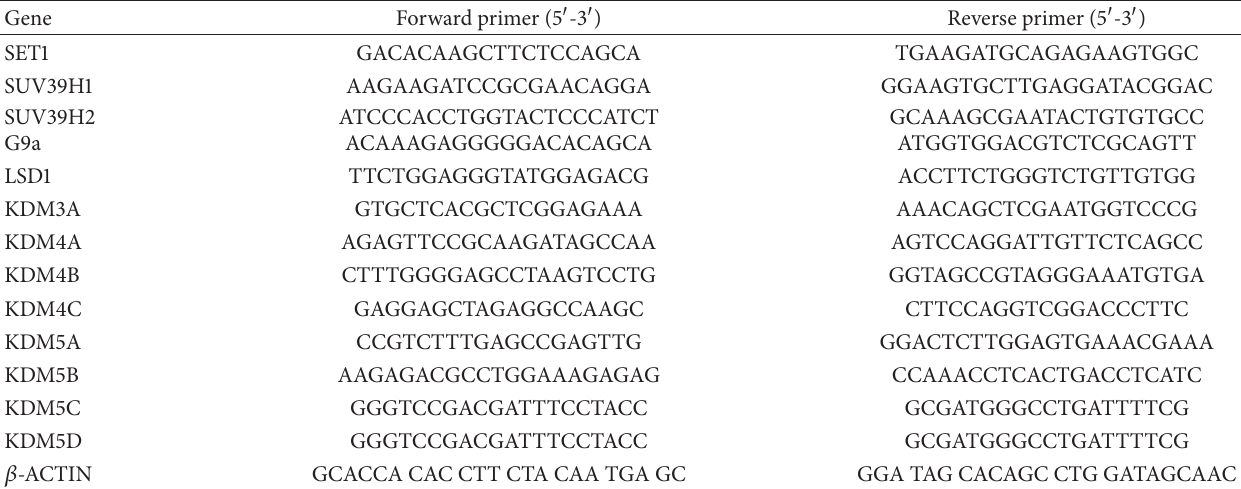
Table 1: Primer sequences used in real-time PCR.